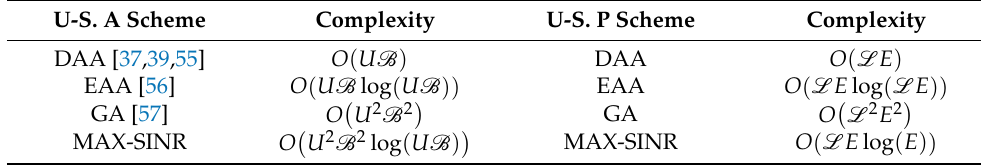
Table 2. Computational complexity of user-slice association, user-slice pairing schemes. U-S. A